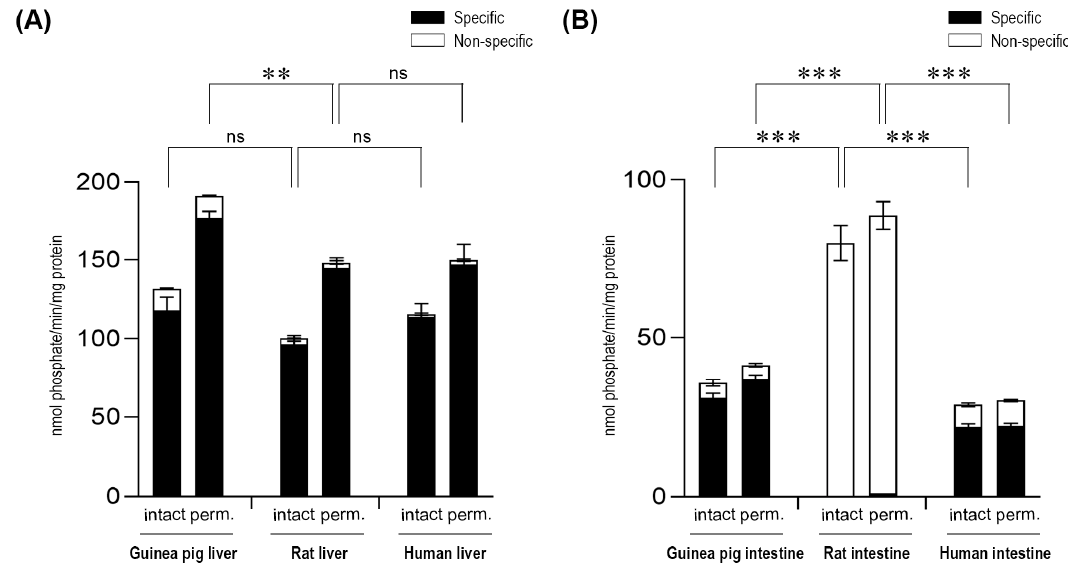
Figure 2. Glucose-6-phosphatase enzyme activity in the liver ( A ) and the intestine ( B ) with the glucose-6-phosphate substrate by measuring phosphate production. All samples were washed three times and incubated at 37 ◦ C in the presence of 10 mM of the glucose-6-phosphate substrate for 10 min. All experiments were performed in triplicate and repeated three times; n = 3 for all species. Bars display mean ± SEM, and statistical analysis was performed using a one-way ANOVA with a Tukey post hoc test with the following significance levels. ns = Non-significant; p = 0.01 − 0.001 ** and p ≤ 0.001 ***. Perm. = Permeabilized microsomes treated with the pore-forming agent alamethicin in 0.05 mg / mg microsomal protein concentration. Intact = Non-permeabilized microsomes containing intact microsomal membranes. Activity measurements were performed by the specific inactivation of G6Pase with a brief exposure of the samples to pH 5.0. Specific G6Pase activity was calculated as the di ff erence between untreated and pH 5.0 treated samples.